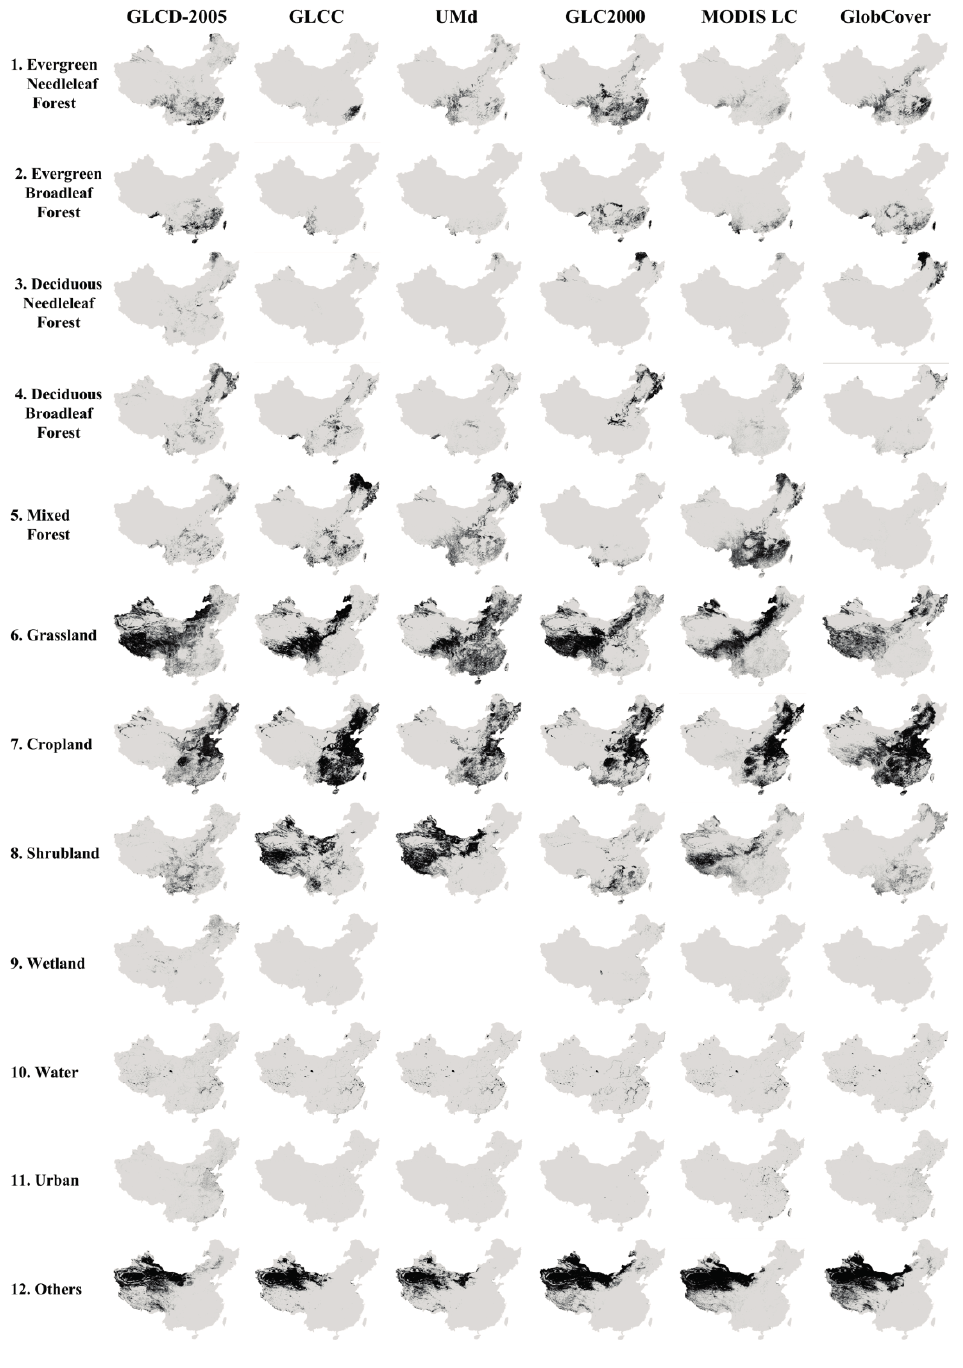
Figure 3. Comparison of the twelve aggregated classes (dark color) for GLCD-2005, GLCC, UMd, GLC2000, MODIS LC, and GlobCover in